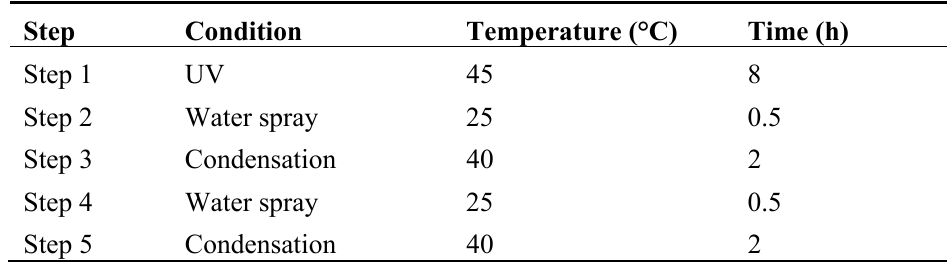
Table 2. Exposure cycle conditions used for the accelerated weathering of PLA plastic